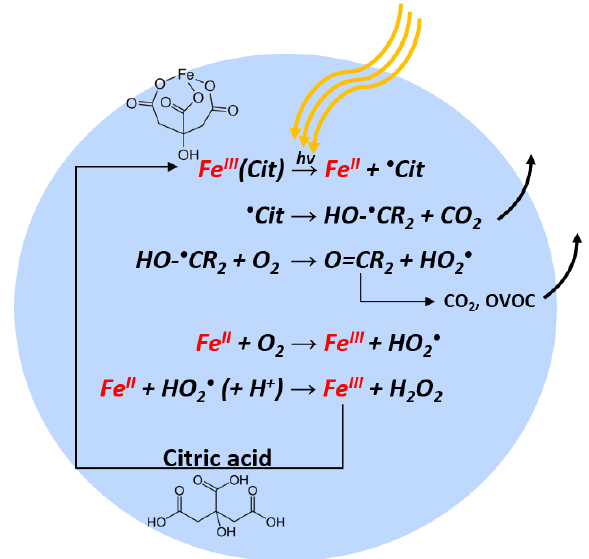
Figure 1. Photocatalytic cycle of Fe III (Cit) complex in an aque- ous particle containing CA with explicit charge balance given in Table 2. R corresponds to the carboxylate side chain − CH 2 COO −